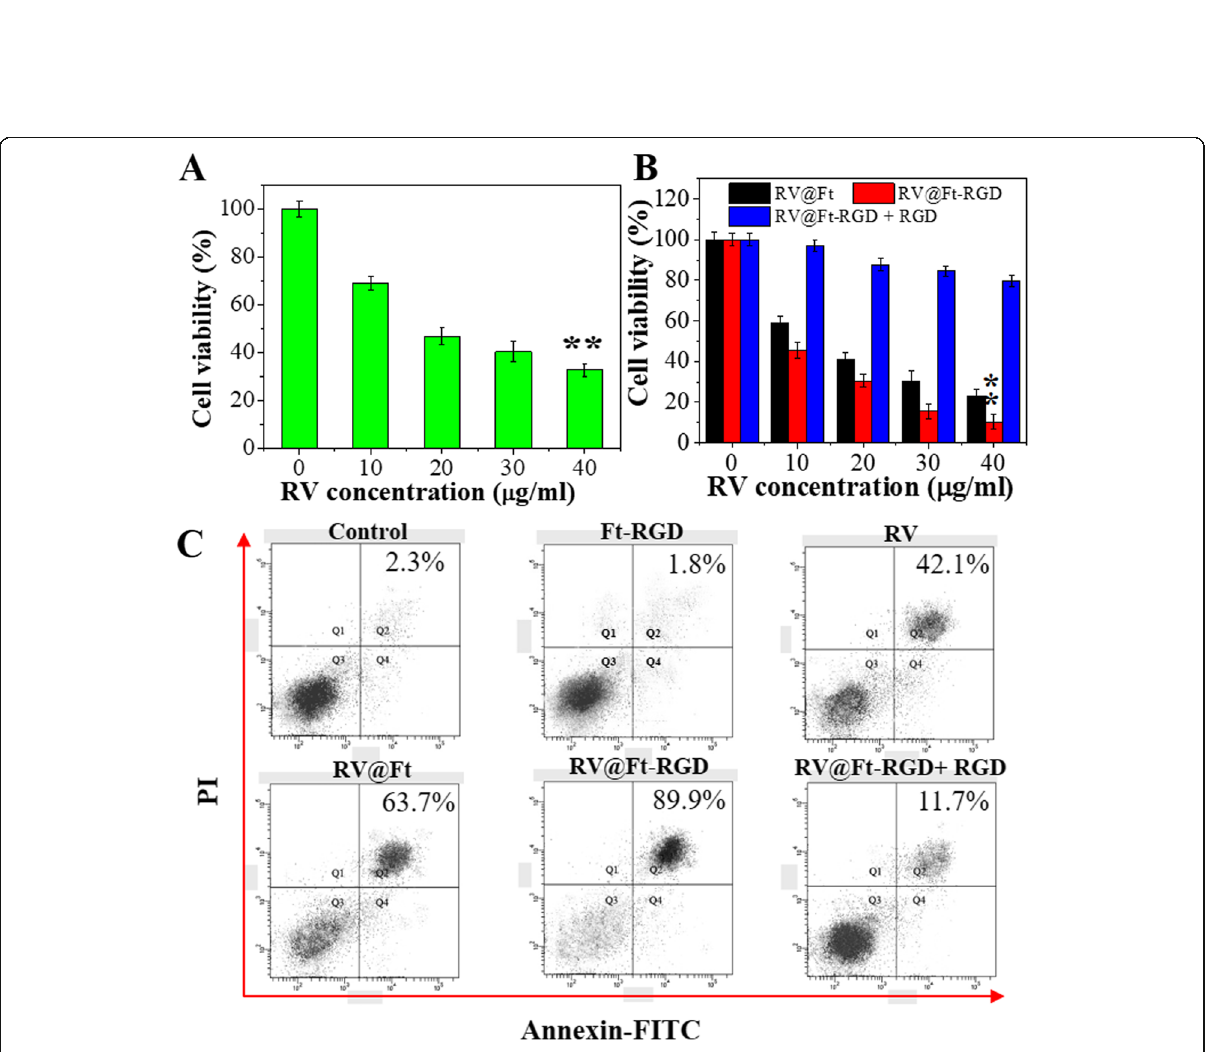
Fig. 6 a Cell viability of different concentration of RV-treated A549 cells. b Cell viability of cells treated with RV@Ft, RV@Ft-RGD + RGD, and RV@Ft-RGD with RV various concentration. c Cell apoptosis of A549 cells treated with PBS (control), RV, RV@Ft, RV@Ft-RGD + RGD, and RV@Ft-RGD by flow cytometry. **P < 0.01, compared with other groups,